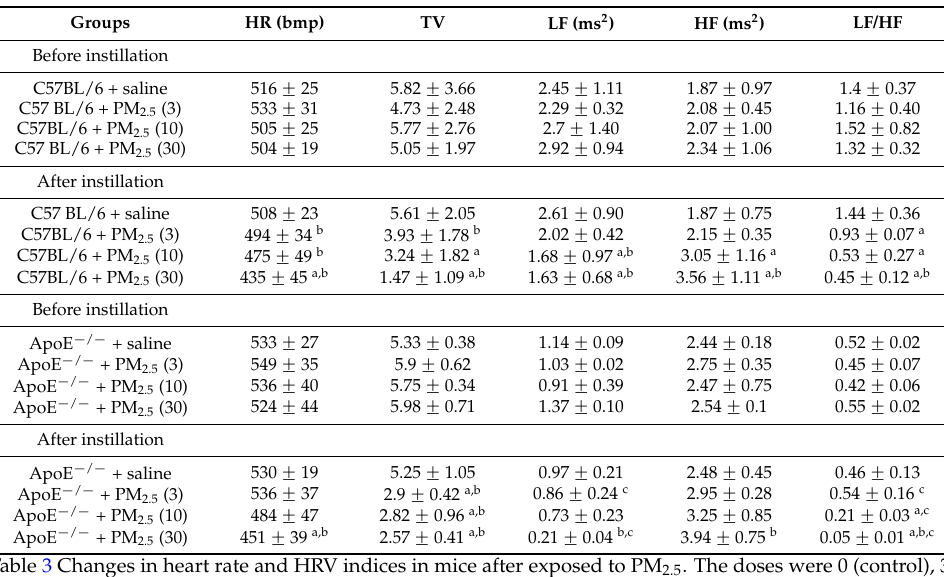
Table 3. Changes in heart rate and HRV indices in experimental groups.